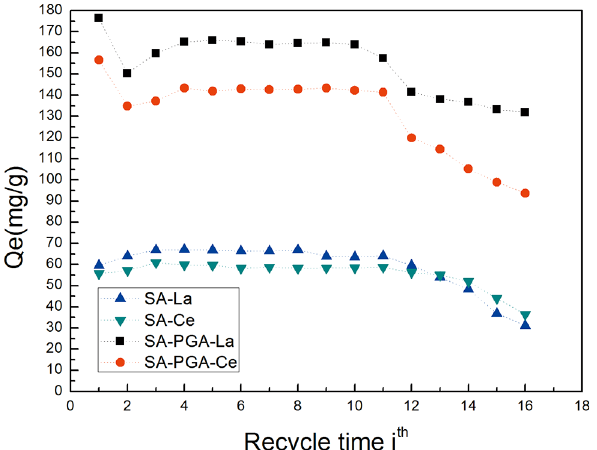
Fig 7. Regeneration of these two gel particles (Adsorption conditions: 30 ml of 0.05 M hydrochloric acid solution, 30 min, 150 rpm,